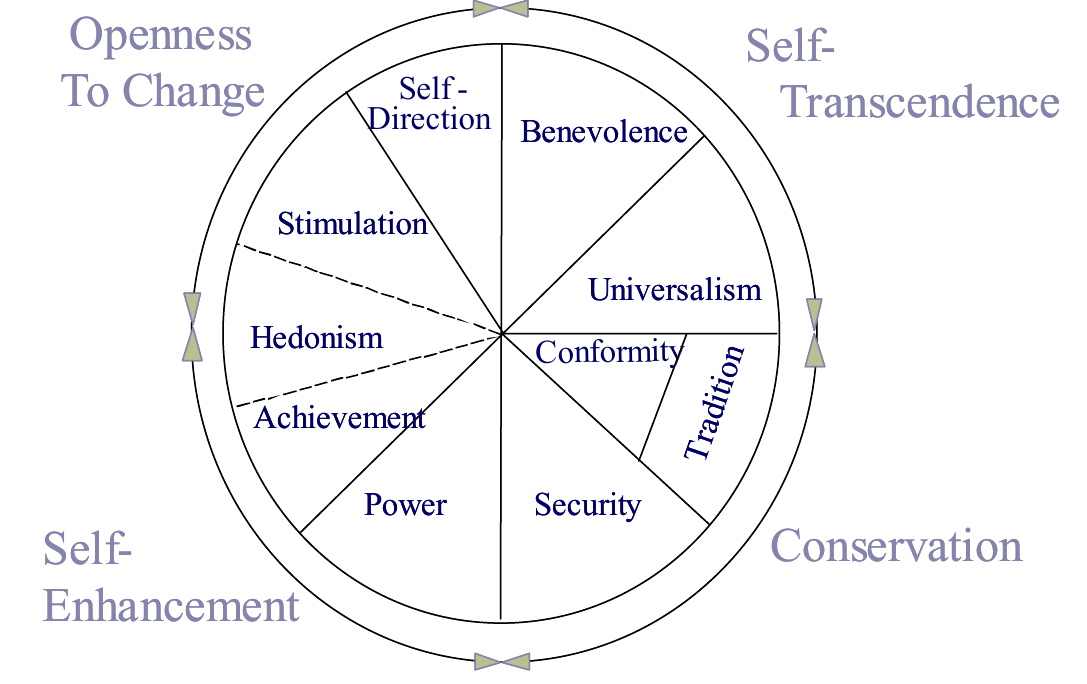
Figure 1: Motivational value types and higher order value domains Note: Adapted from Schwartz